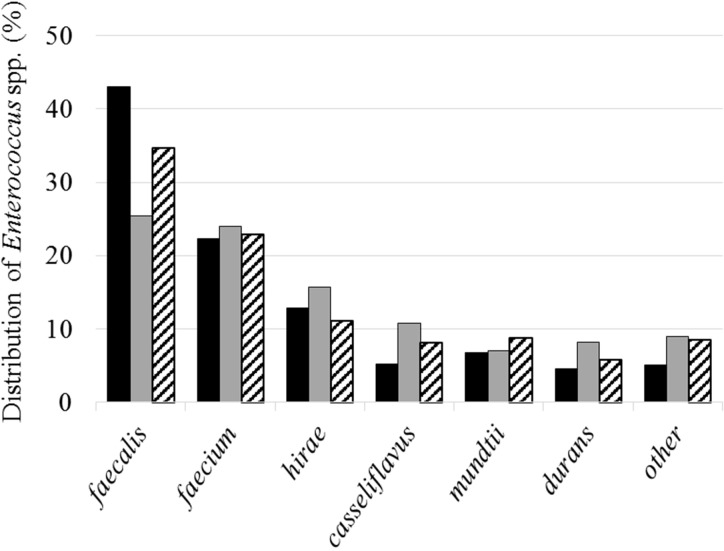
Distribution of the main isolated species. Black, gray and hatched bars represent results from sites 1, 2, and 3, respectively.